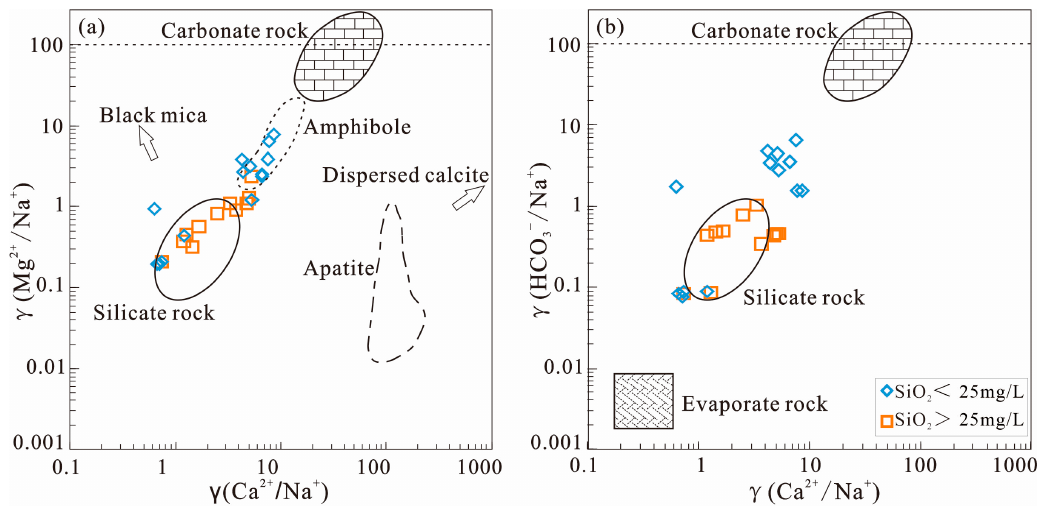
Figure 4. The relationship of Ca 2+ /Na + and Mg 2+ /Na + ( a ), Ca 2+ /Na + and HCO 3 − /Na + ( b ) in the study area.